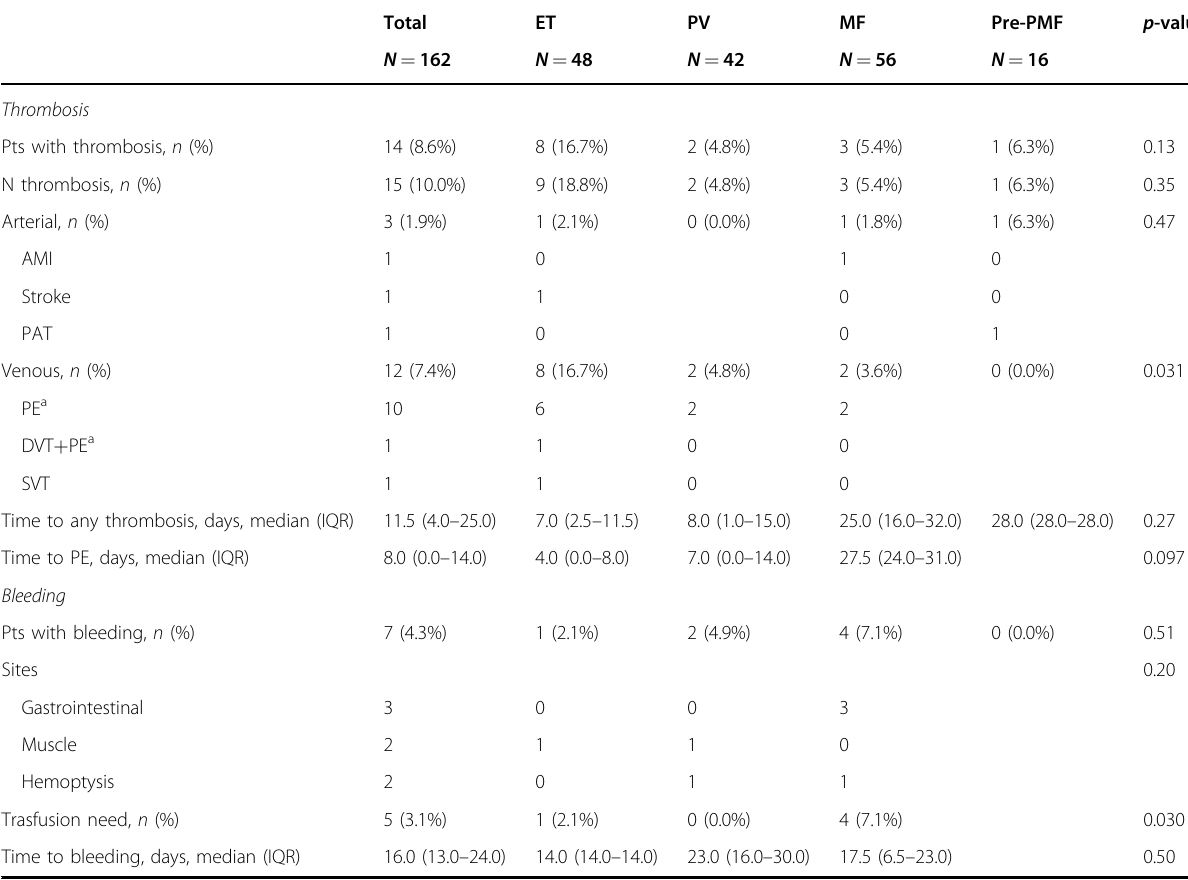
Table 1 Types of thrombosis and bleeding, by MPN